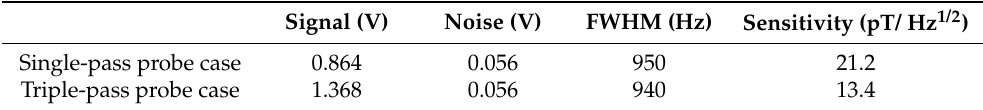
Table 1. Parameters for the single-pass and the triple-pass probe beam cases of FID magnetometers. Signal (V) Noise (V) FWHM (Hz) Sensitivity (pT/ Hz 1/2 ) Single-pass probe case 0.864 0.056 950